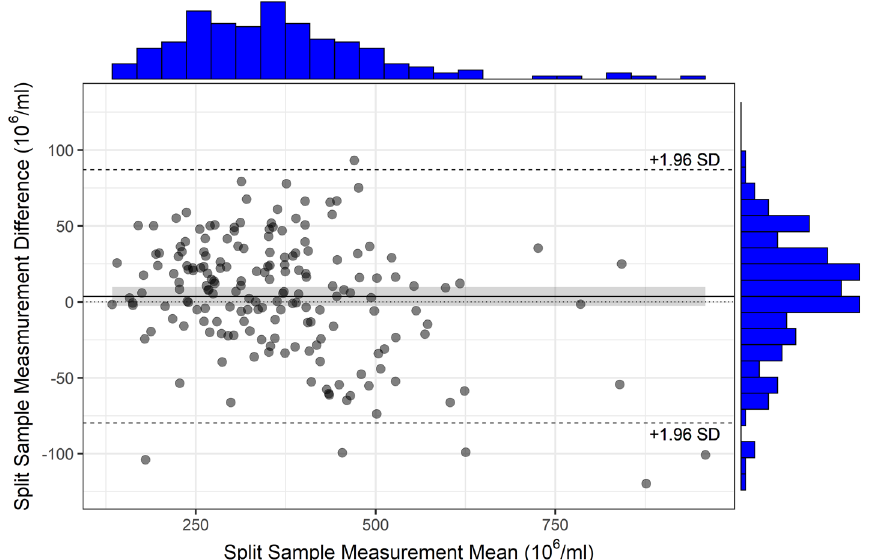
Figure 3. Bland–Altman plot of split-sample measurements of sperm concentration with ANDROVISION eFlow and NUCLEOCOUNTER (reference method). 95.1% of all measurements lie within mean ± 1.96 SD. The confidence interval (shaded area) of the mean of the absolute differences (± 6.13 × 10 6 , CI = − 2.51 × 10 6 – 9.75 × 10 6 ) includes the